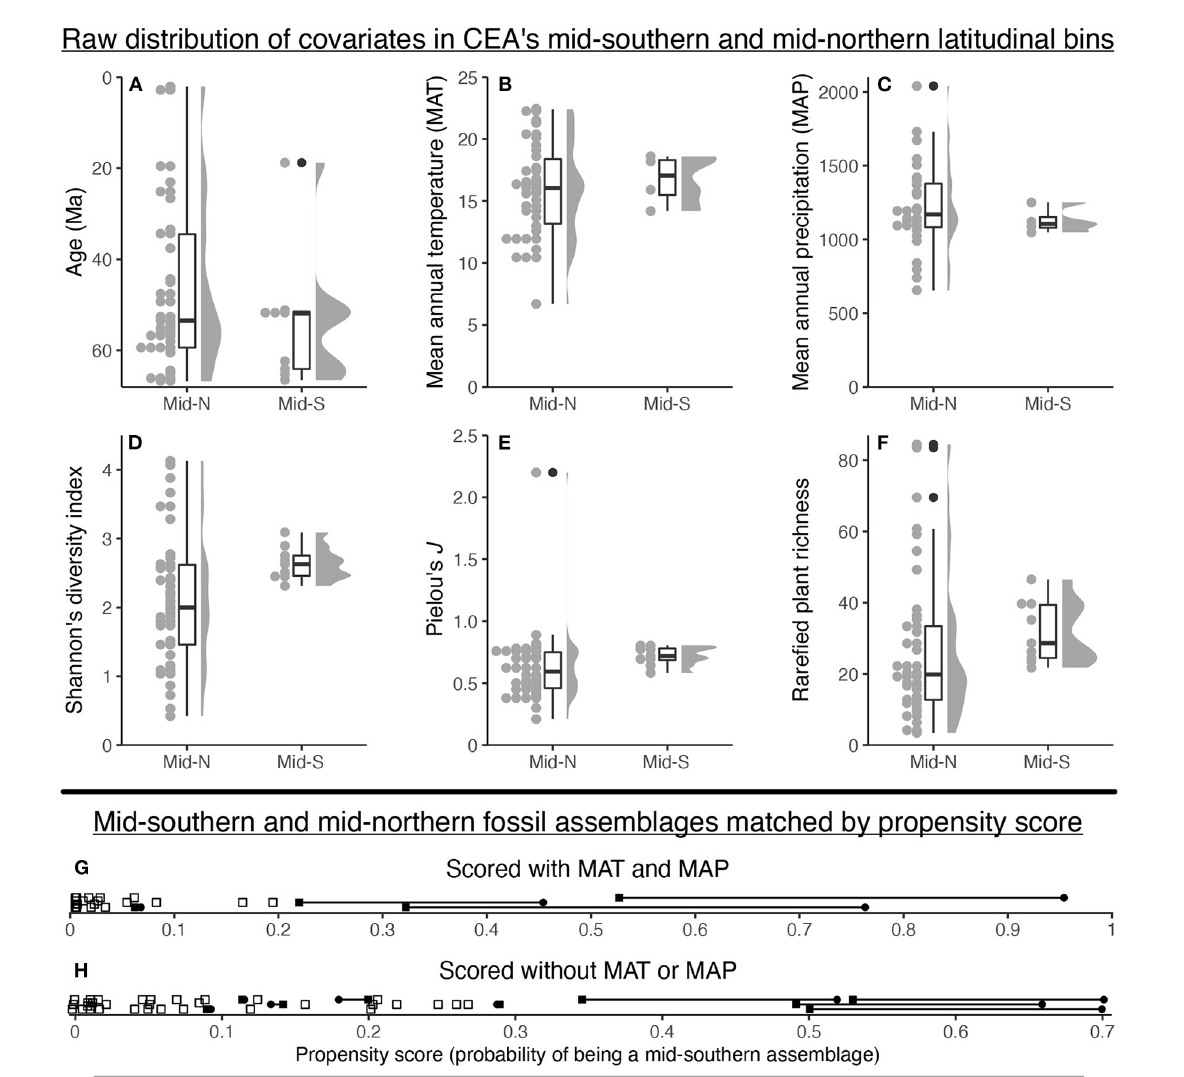
FIGURE6 The distribution of various covariates for Currano et al. (2021)’s mid-northern and mid-southern latitudinal bins (A–F) , and the results of propensity score matching for these bins (G,H)